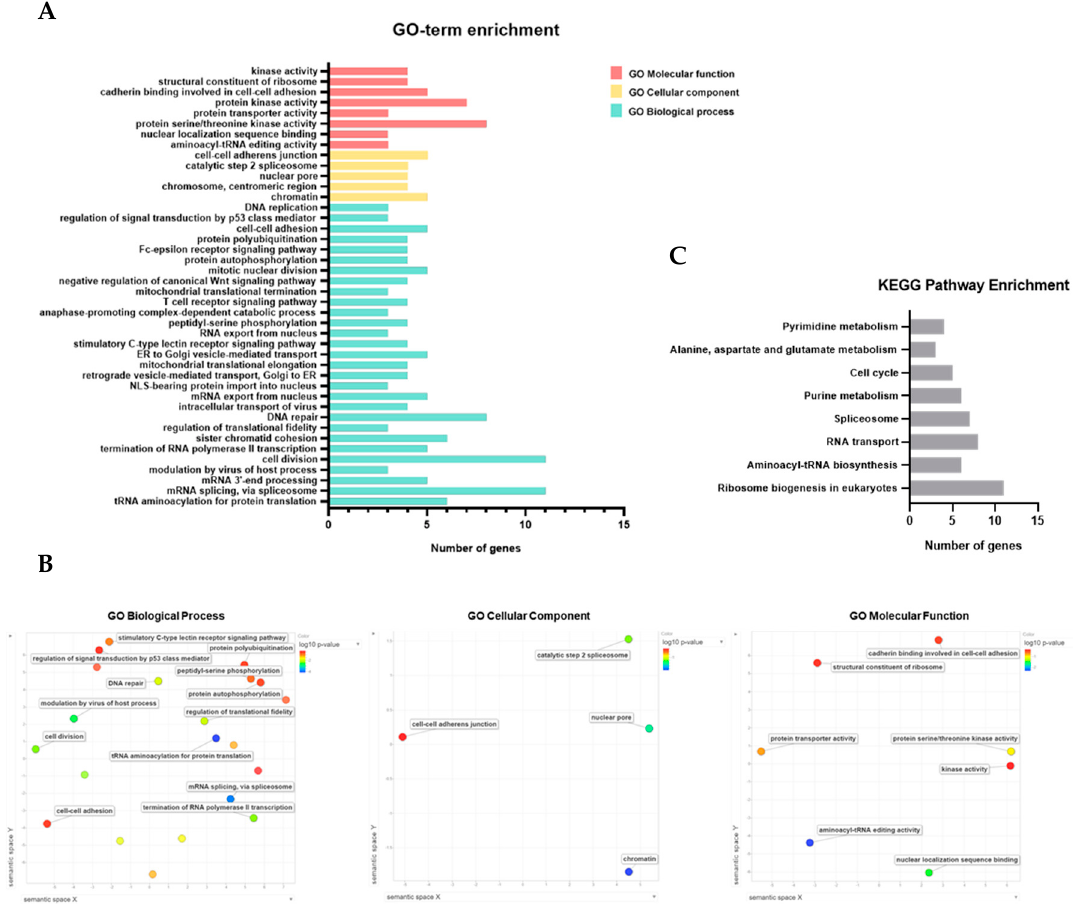
Figure 6. Functional enrichment analysis of JMJD10 in stomach adenocarcinoma. ( A ) Box plot representing enriched GO terms includes GO molecular function, cellular component, and biological process enrichment. ( B ) Semantic similarity-based scatterplots of GO-term enrichment results; the axes have no intrinsic meaning; semantically similar GO terms are closer together in the plot. ( C ) Box plot representing KEGG pathway enrichment results.